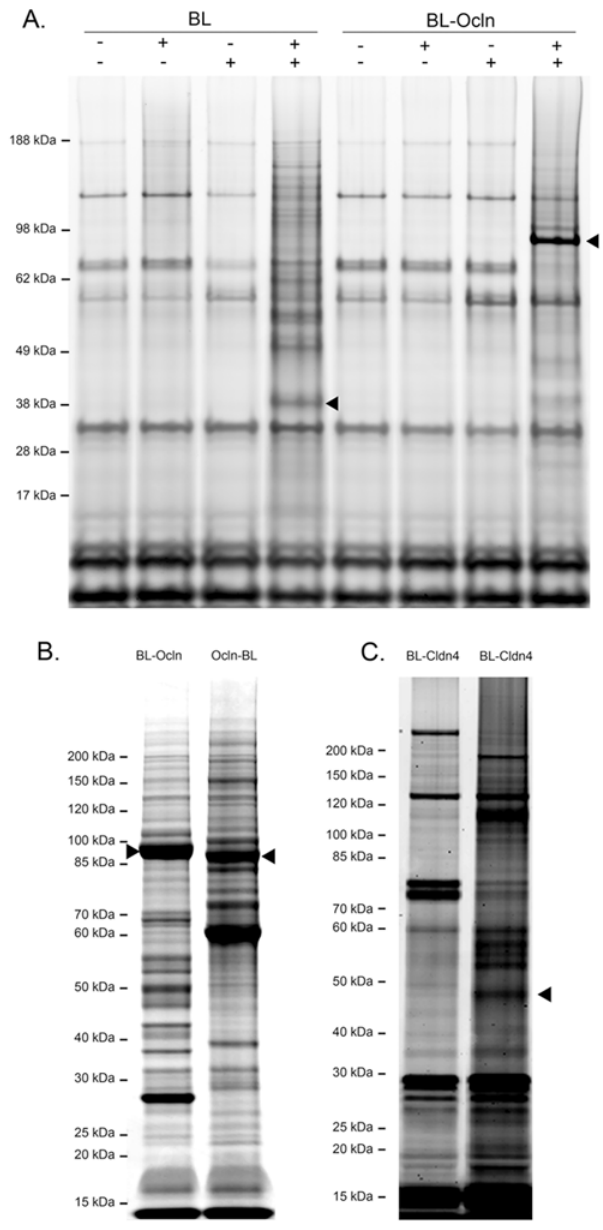
Fig 3. Coomassie-stained SDS-PAGE gels reveal that streptavidin-purified biotinylated proteins from different transgenes show differing protein patterns. A . Shown are proteins purified from cells expressing biotin ligase alone ( BL ), biotin ligase fused to the N terminus of Ocln ( BL-Ocln ). B . Proteins purified from the N- and C- terminus of Ocln (BL-Ocln and Ocln-BL) with added biotin. C . Shown are proteins purified from cells expressing biotin ligase fused to the N terminus of Cldn4 ( BL-Cldn4 ), with or without added biotin. The positions of the transgenes are marked with arrowheads . Triplicate samples gave very similar protein